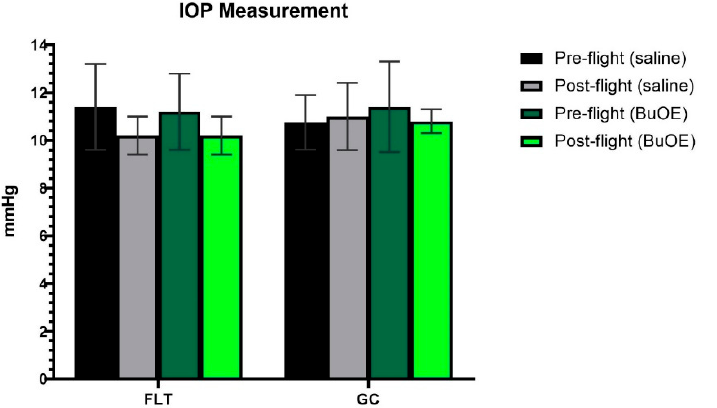
Figure 2. Intraocular pressure (IOP) measurements. Each bar represents the mean counts from the left or right eyes of pre- and post-flight IOP for flight (FLT) and ground control (GC) mice (n = 8). Six readings were made to obtain an average count as a single IOP readout. Values are the means ± SEM.